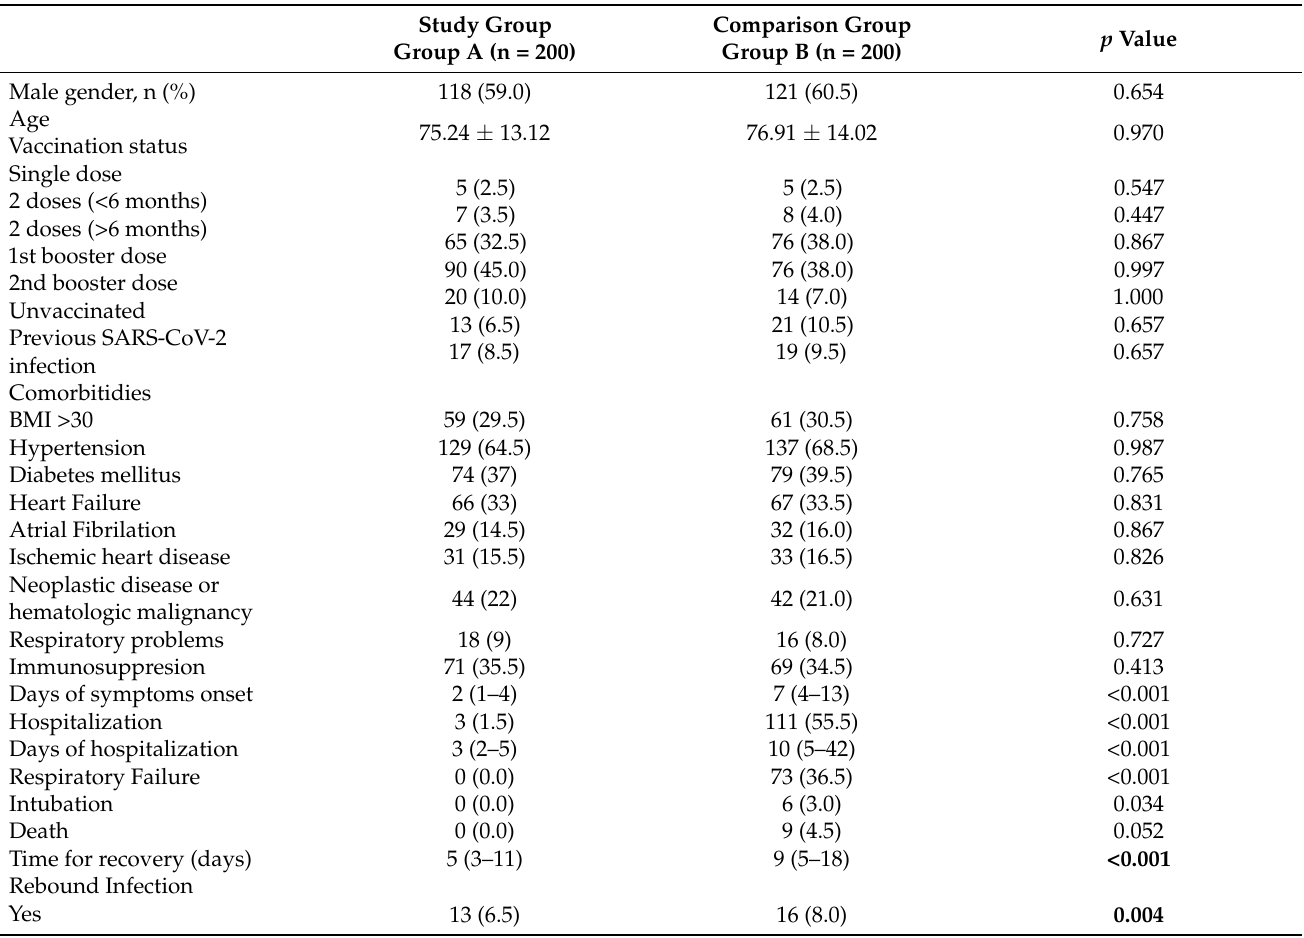
Table 1. Demographic data, vaccination status, comorbidities and clinical characteristics of Group A (un-hospitalized patients treated with nirmatrelvir/ritonavir) and Group B (untreated patients with oral antivirals).